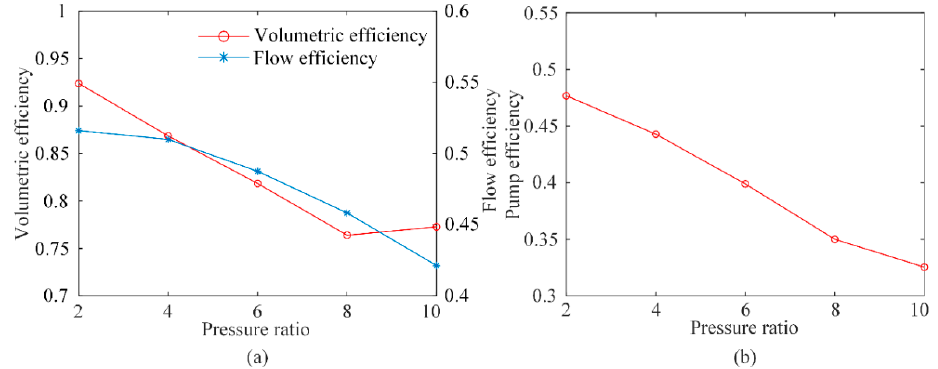
Figure 20. Efficiencies of the Roots pump under various pressure ratios. ( a ) volumetric efficiency and flow efficiency; ( b ) pump efficiency.